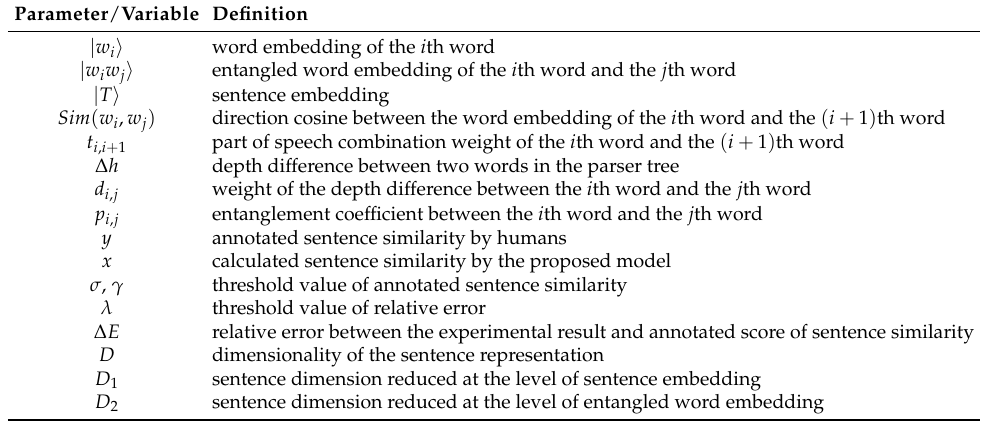
Table 1. Definitions of the parameters and